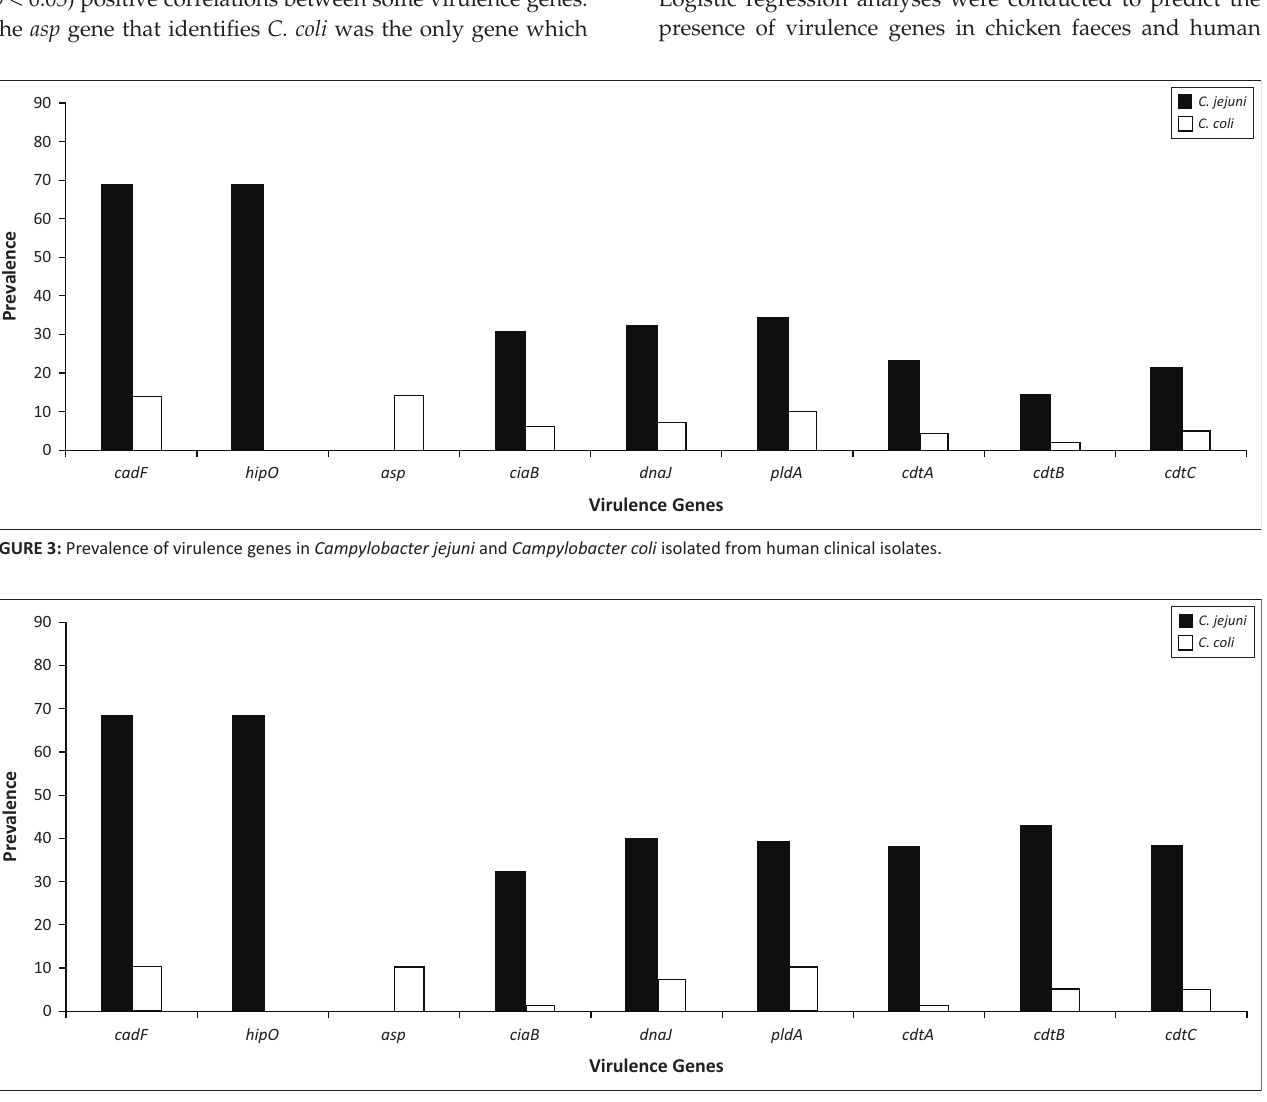
FIGURE 4: Prevalence of virulence genes in Campylobacter jejuni and Campylobacter coli isolated from chicken